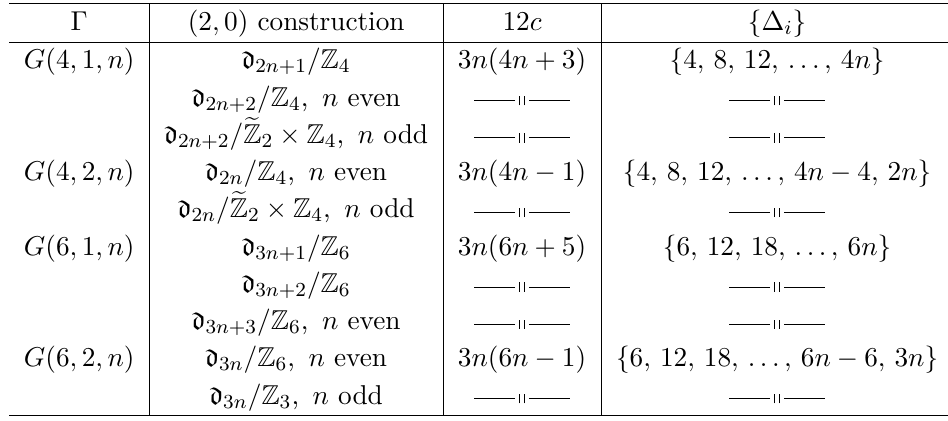
Table 3 . 4d N = 3 theories obtainable from type- d N (2,0)